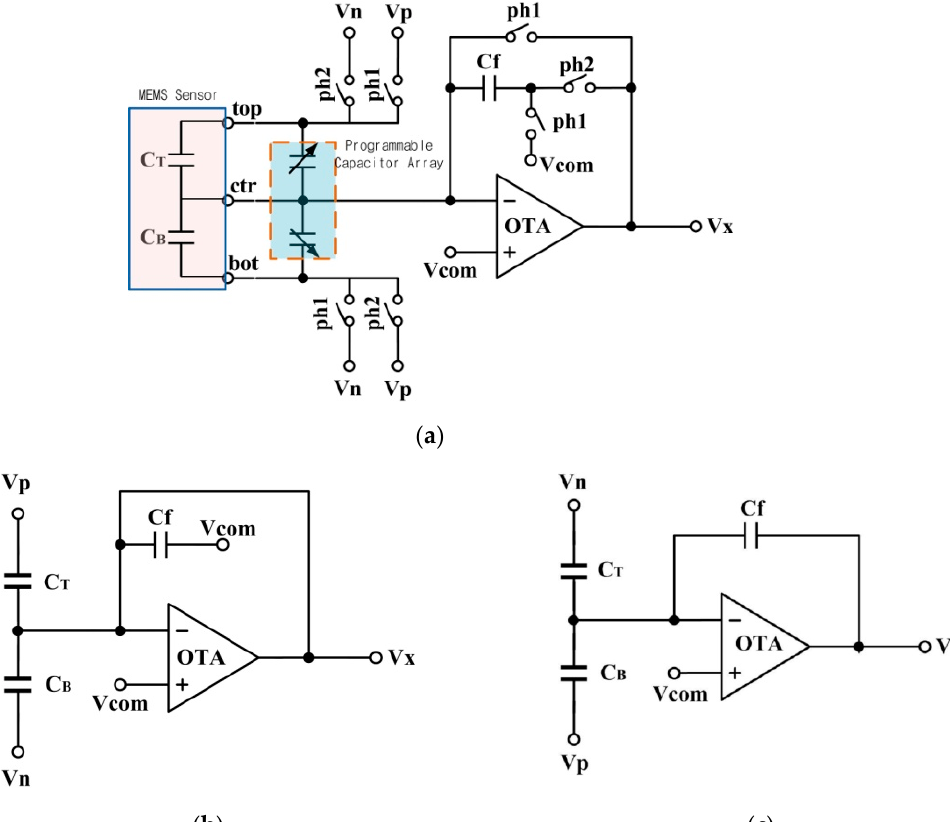
Figure 4. ( a ) Structure of the MEMS readout circuit with CDS technique; ( b ) Equivalent circuit of PH 1 stage; ( c ) Equivalent circuit of PH 2 stage.